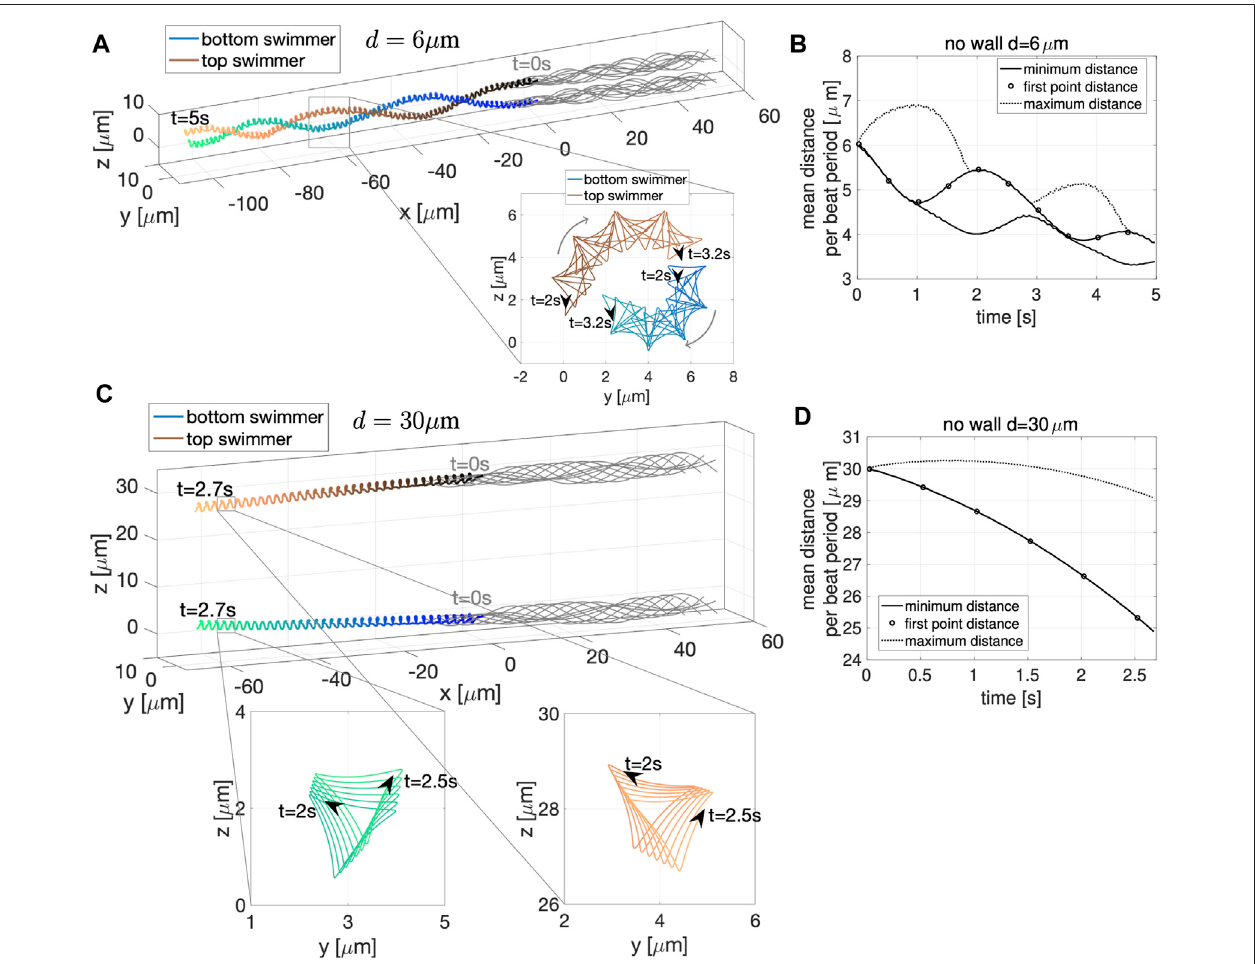
FIGURE 9 | Quasi-Planar Swimmers in Free Space. 3D fl agellar con fi gurations for the fi rst beat period (gray lines) and the trajectory ofthe fi rst point in the direction ofswimming(coloredlineswithrespecttotime)overthespeci fi edtimeintervalforthetwoswimmers,initializedatadistance d (cid:1) 6 μ mapartin (A) and d (cid:1) 30 μ mapartin (C) . The curves traced by the fi rst point of the two swimmers on the yz -plane over the speci fi ed time interval are shown in the corresponding zoomed-in portions. Minimum (solid line) and maximum (dotted line) distance between the two swimmers and distance between the fi rst points (circles) with respect to time for initial distance d (cid:1) 6 μ m in (B) and d (cid:1) 30 μ m in (D) (averages over a beat